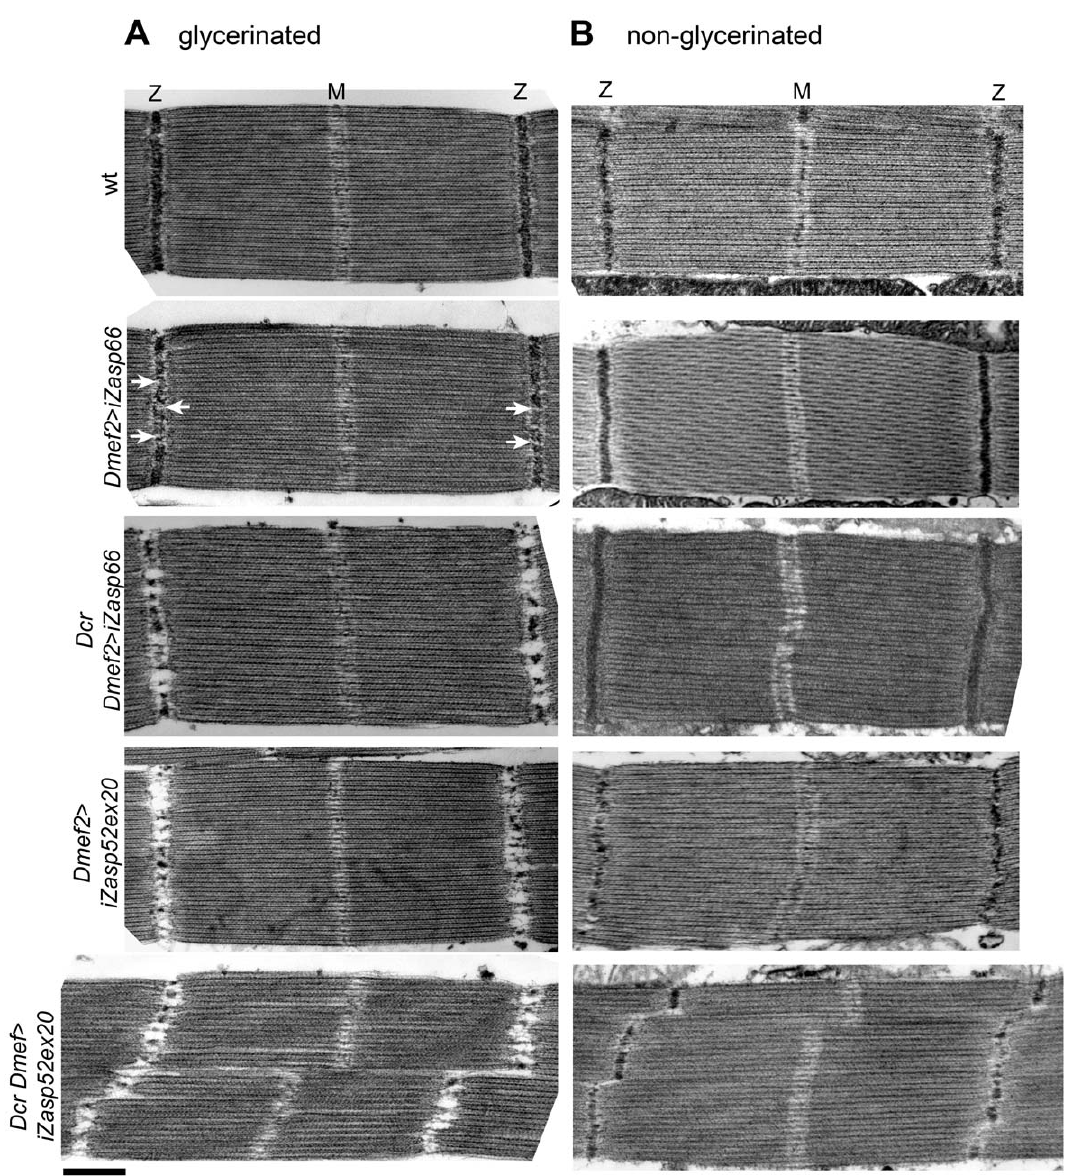
Figure 8. Zasp66 and Zasp52 stabilize Z-discs. Electron micrographs of wild type, Dmef2 . iZasp52ex20, and Dmef2 . iZasp66 IFM with and without Dcr. (A) Sarcomere structure of IFMs treated with glycerol and Triton-X 100. Dmef2 . iZasp66 sarcomeres show mild defects in their Z-disc structure. Small pockets with missing Z-disc material are visible (arrows). Sarcomeres of Dcr Dmef2 . iZasp66 flies have little Z-disc material left, similar to sarcomeres of Dmef2 . iZasp52ex20 flies. Sarcomeres of Dcr Dmef2 . iZasp52ex20 flies show severely distorted Z-discs and H-zones. (B) Sarcomere structure of IFMs without glycerol and Triton X-100 treatment. Dmef2 . iZasp66 sarcomeres look like wild type. Sarcomeres of Dmef2 . iZasp66 flies enhanced with Dcr occasionally show shifted H-zones and slightly bent Z-discs. Dmef2 . iZasp52ex20 sarcomeres with or without Dcr lack Z-disc material, but show a milder phenotype than in (A). Scale bar, 500 nm.